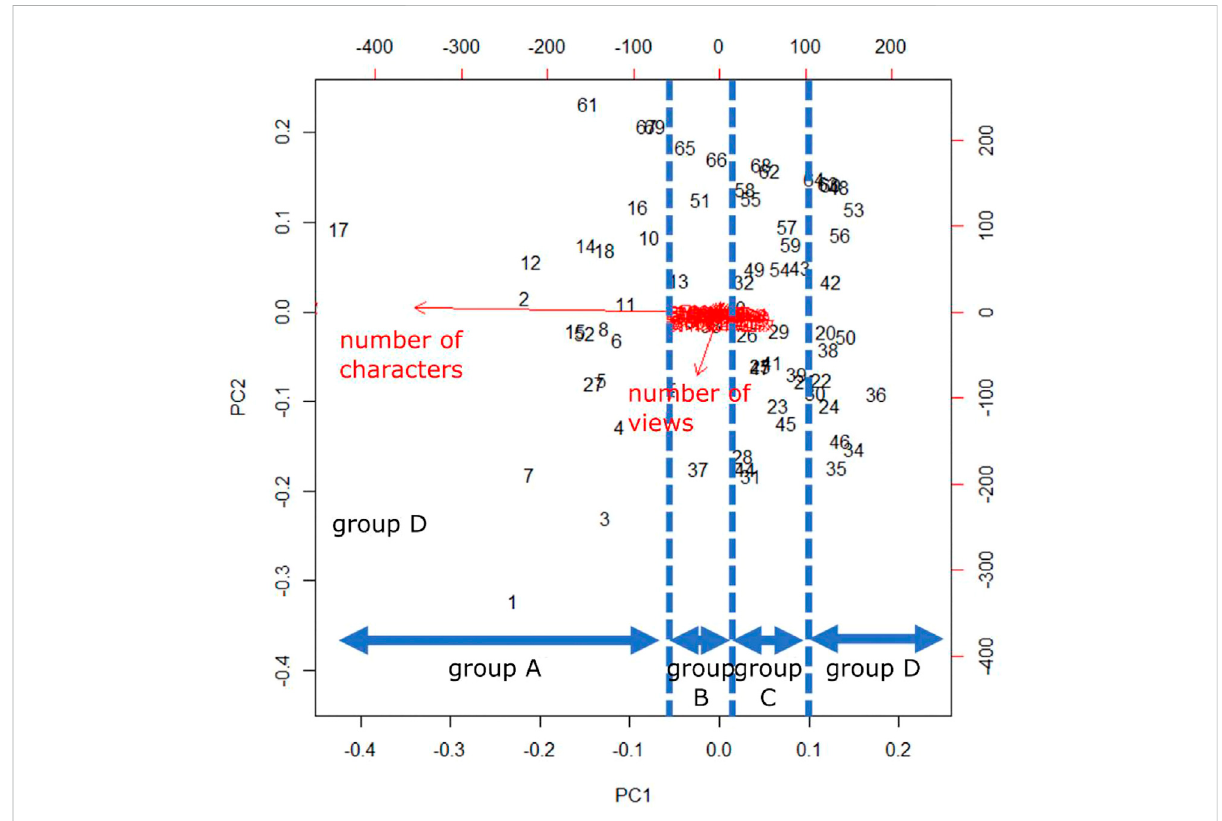
FIGURE 12 Results of principal component analysis for 76 content related to book